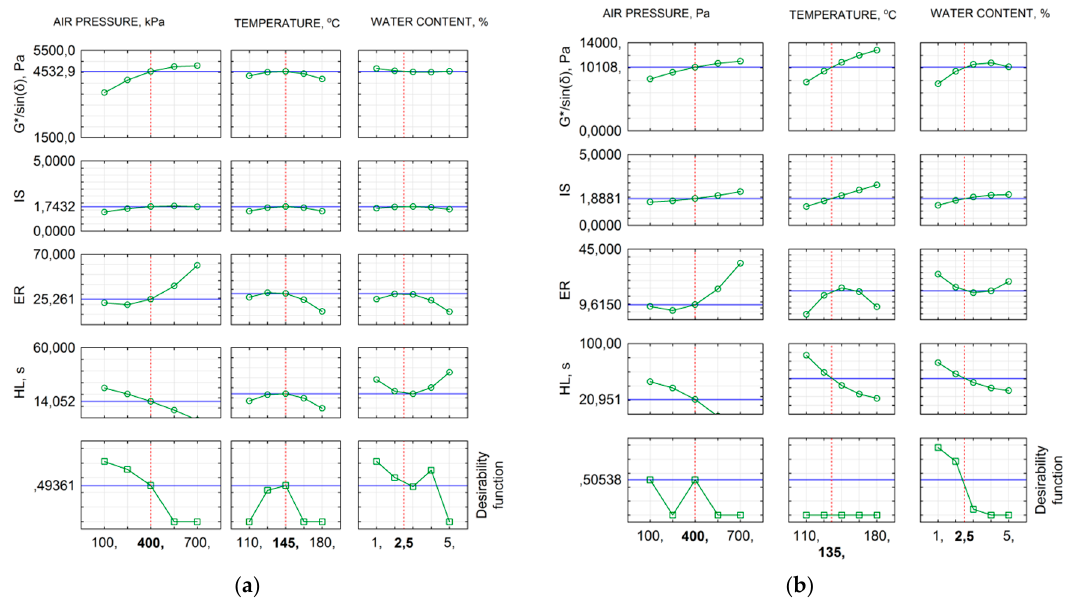
Figure 11. Optimisation outcomes: ( a ) bitumen 50/70; and ( b ) bitumen 50/70 M (2.5% FT wax).